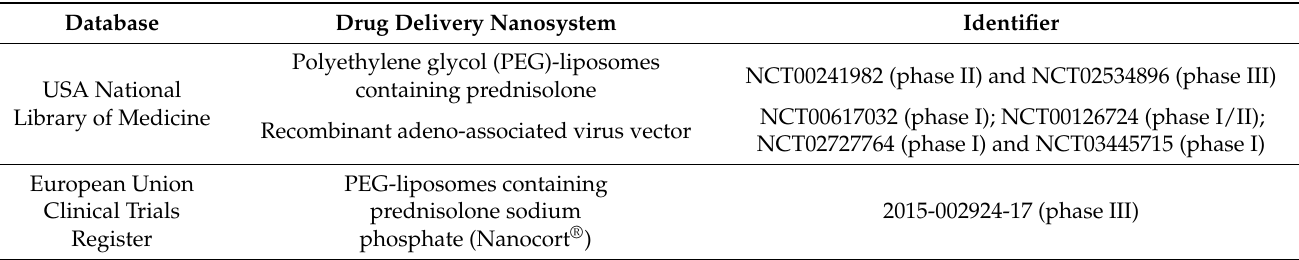
Table 2. Drug delivery nanosystems currently in clinical trials for rheumatoid arthritis treatment.